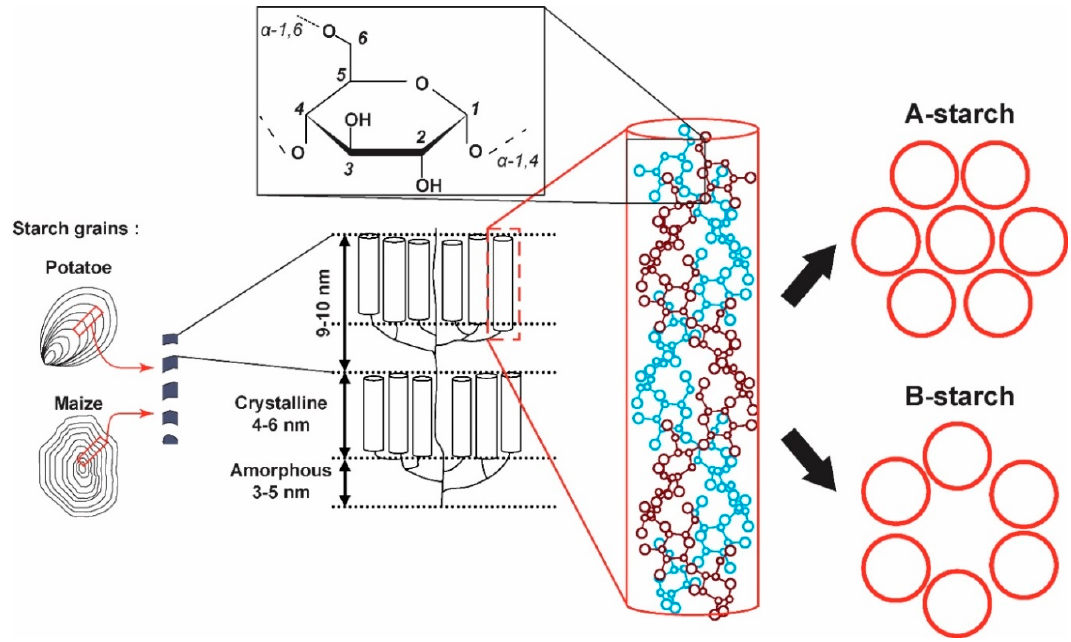
Figure 1. Multiscale representation of starch, from left to right: morphology of starch granules [17], crystalline and amorphous regions, double helices and packing of double helices in crystalline forms A and B.